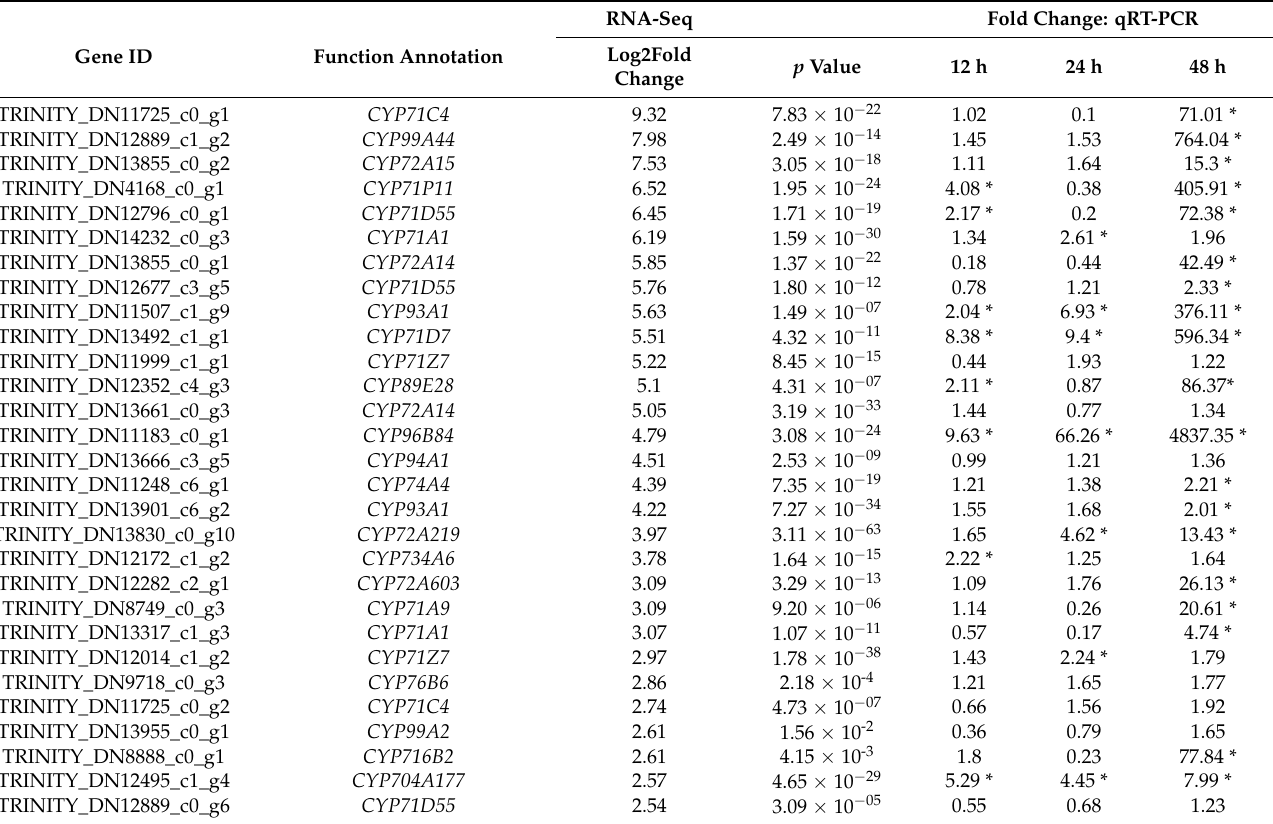
Table 1. Selection and validation of P450 genes in resistant Beckmannia syzigachne population when comparing those with and without herbicide